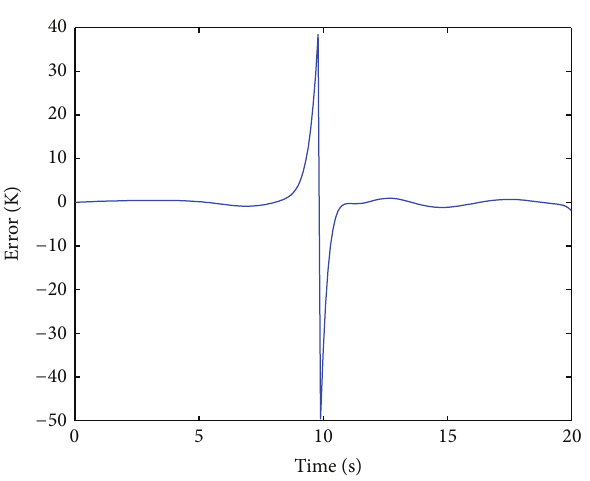
Figure 6: Controlled variable.